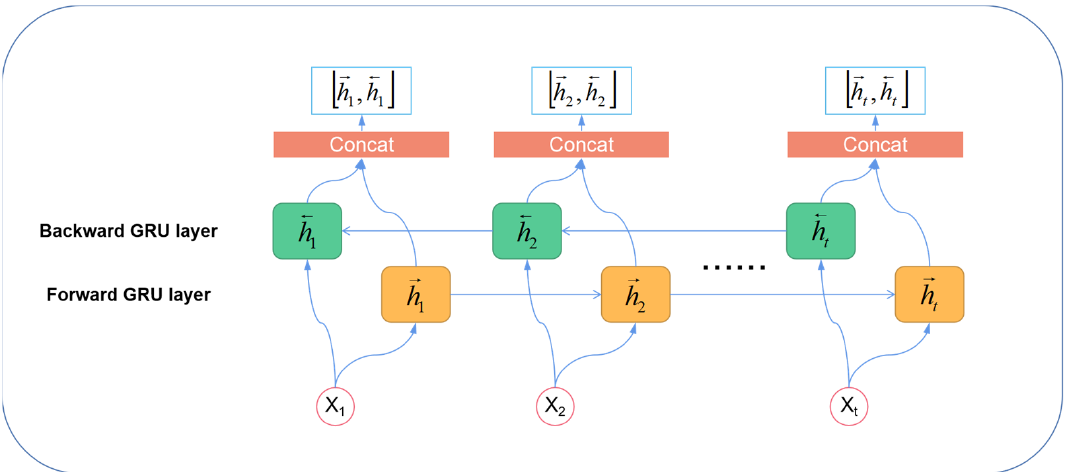
Figure 2. The BIGRU structure.